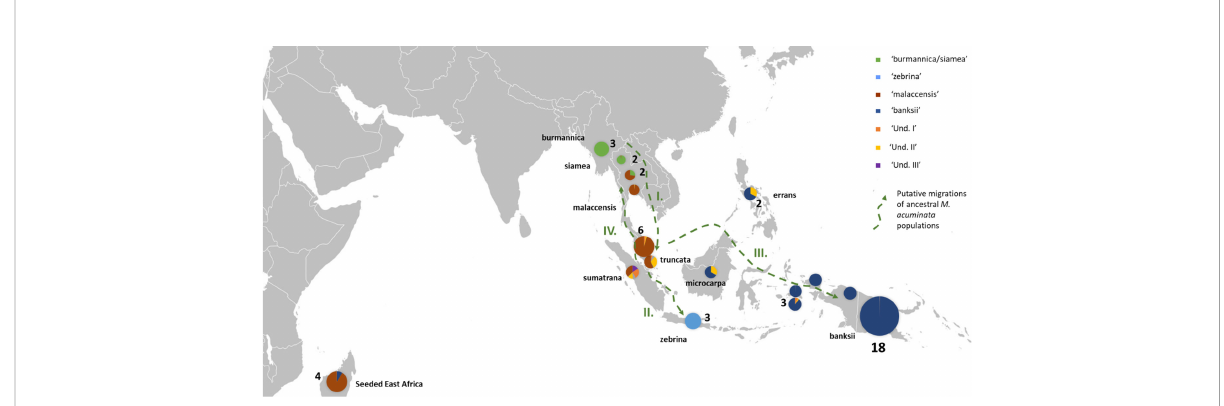
FIGURE 2 Distribution of the M. acuminata accessions of the sample. The pie charts illustrate genomic background (as inferred by STRUCTURE for k=8) and the numbers indicate the number of accessions sharing similar patterns. Putative dispersal roads of ancestral populations are represented by green dashed arrows. I. First dispersion from mainland South-East Asia towards the Malayan Peninsula and Sumatra, followed by II. Dispersal of populations to Java, III. dispersal to Borneo, the Philippines and New Guinea Island and IV. Secondary colonization of mainland South-East Asia. ‘ Und.I ’ , ‘ Und. II ’ and ‘ Und. III ’ correspond to genepools for which no parental populations were identi fi ed in the samples.